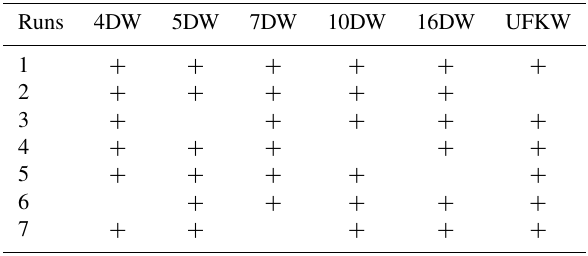
Table 1. Scenarios of model calculations, including different PWs. Runs